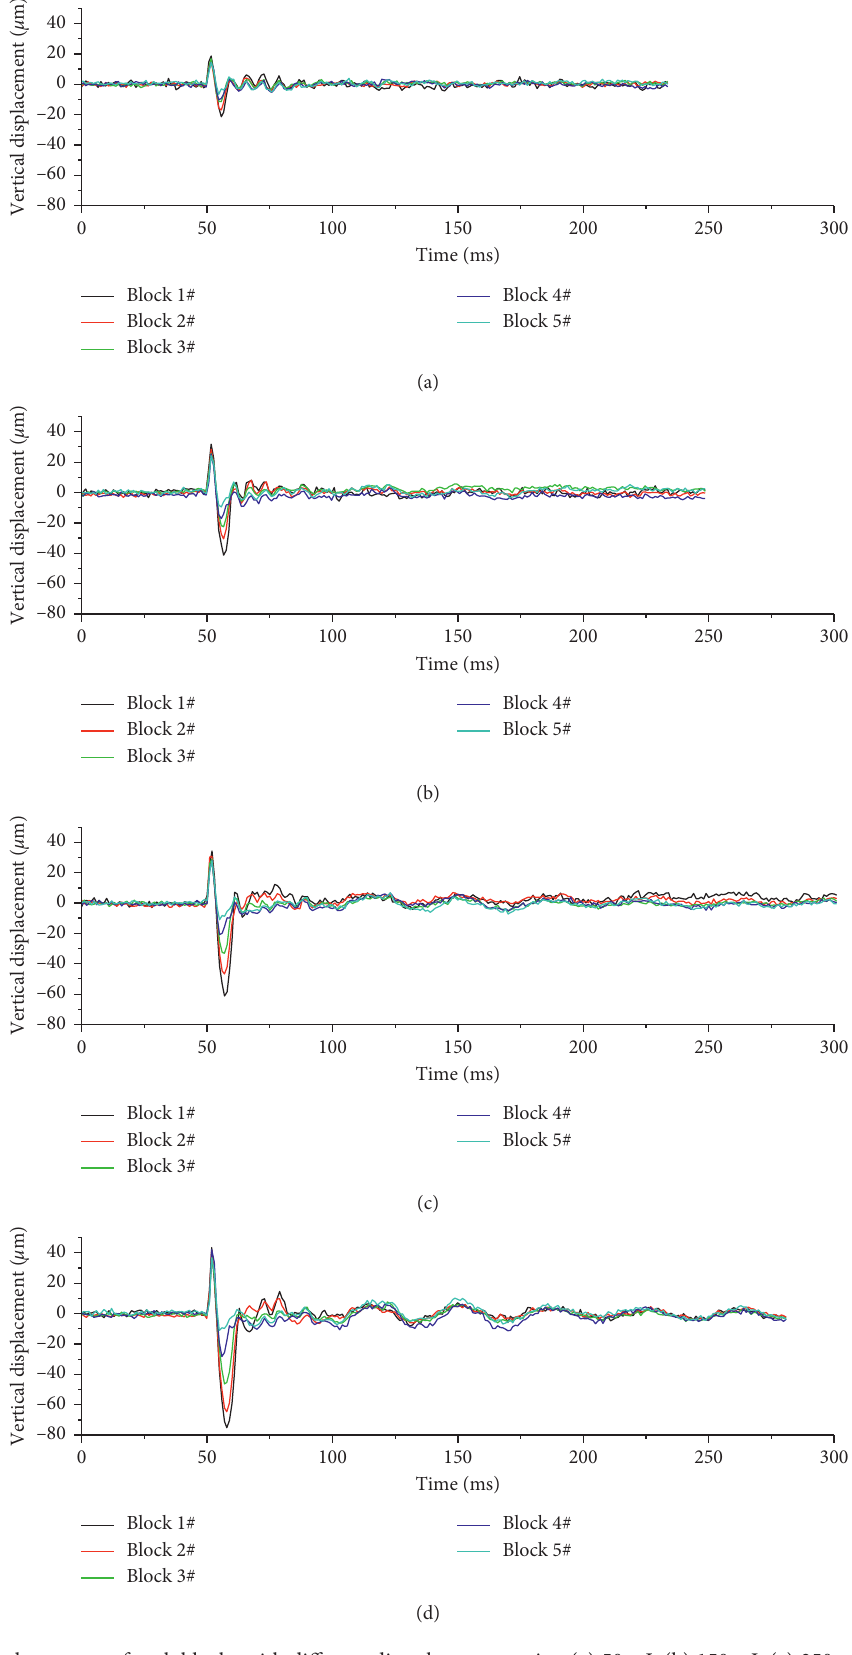
Figure 4: Vertical displacements of rock blocks with different disturbance energies: (a) 50 mJ; (b) 150mJ; (c) 250mJ; (d) 300mJ. Positive values indicate the compression displacements, while negative ones do the